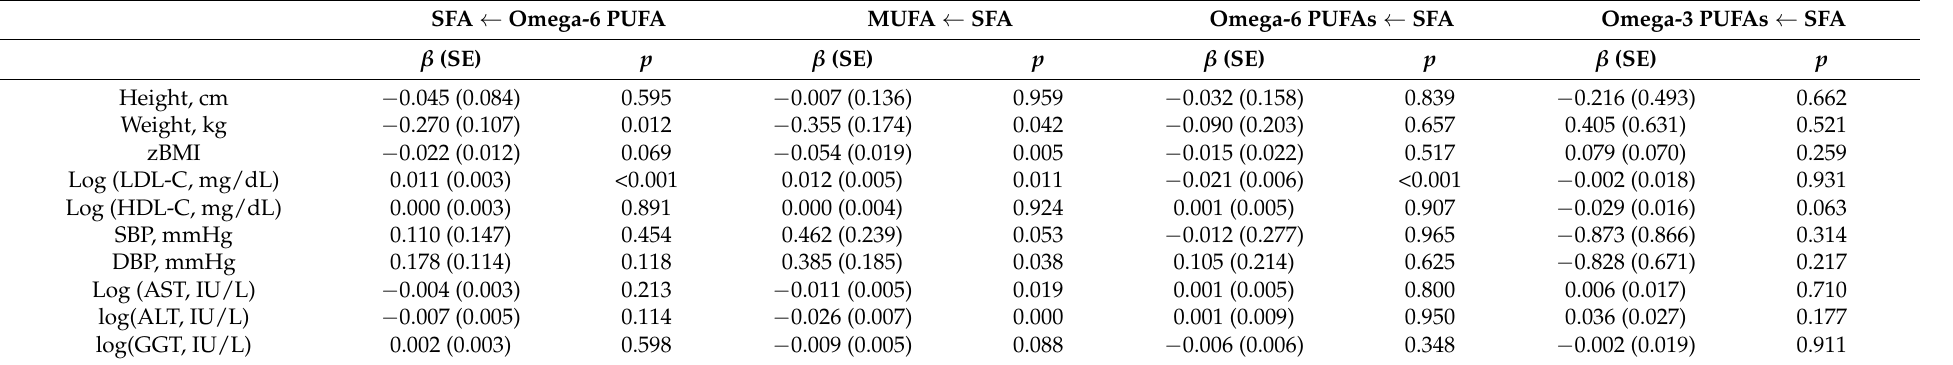
Table 4. Traditional substitution